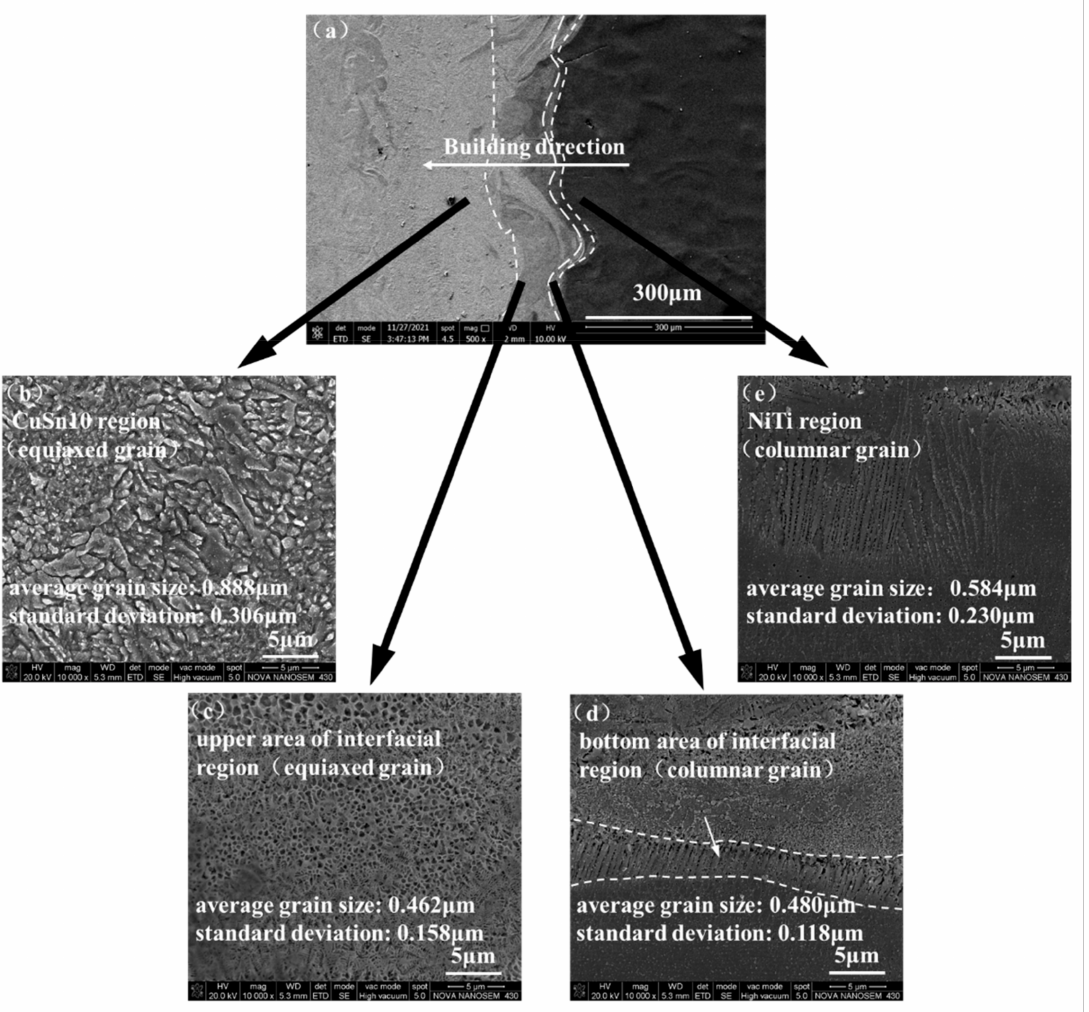
Figure 5. The microstructure of ( a ) NiTi/CuSn10 interface (500 × ); ( b ) CuSn10 region (10,000 × ); ( c ) upper area of interfacial region (10,000 × ); ( d ) bottom area of interfacial region (10,000 × ); ( e ) NiTi region (10,000 ×